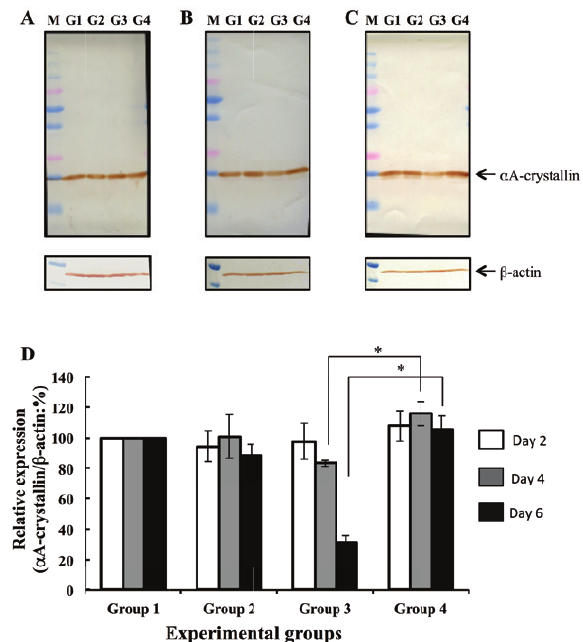
Figure 2: Western blot analyses to determine a A-crystallin levels.